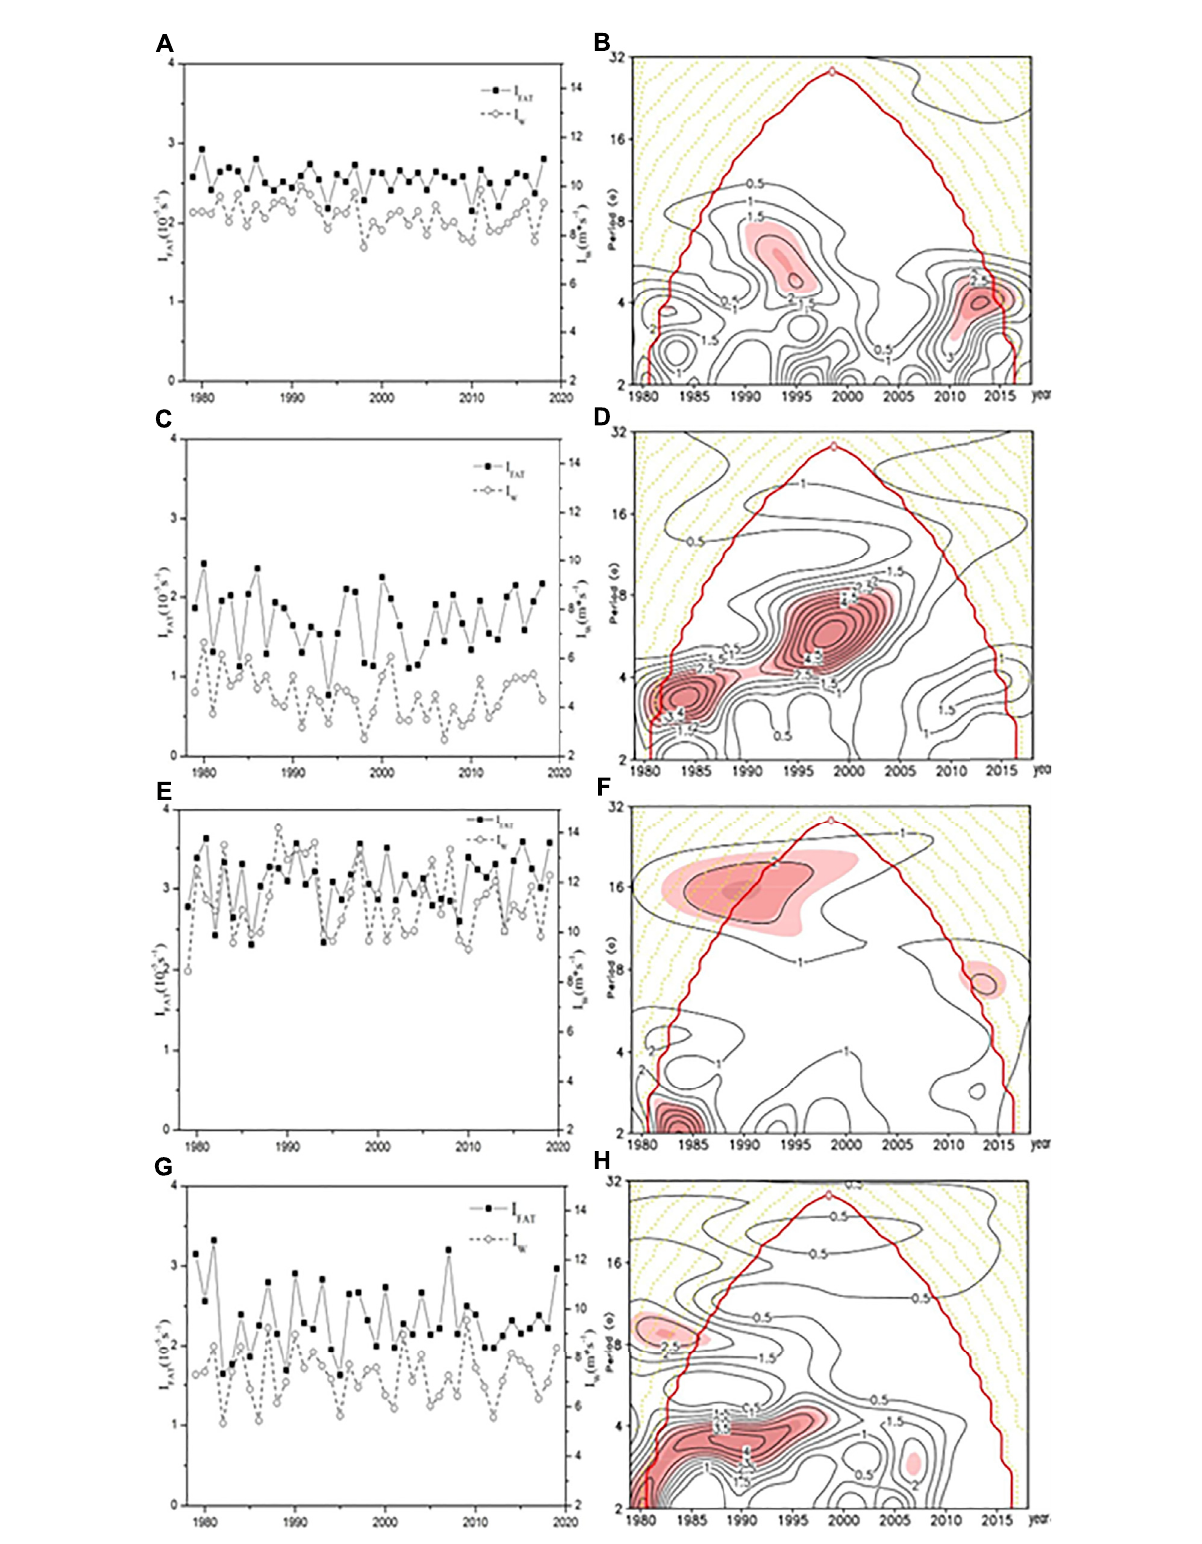
FIGURE 5 The time series of I FAT (solid line and square), and I W (dashed line andcircle) in (A) winter half-year, (C) autumn, (E) winter, (G) spring. The wavelet power spectrum for I FAT in (B) winter half-year, (D) autumn, (F) winter, (H) spring. The shaded areas in B, D, F and H indicate statistical signi fi cance 0.05 level, and dotted line areas indicate the cone of the wavelet in fl uence by the